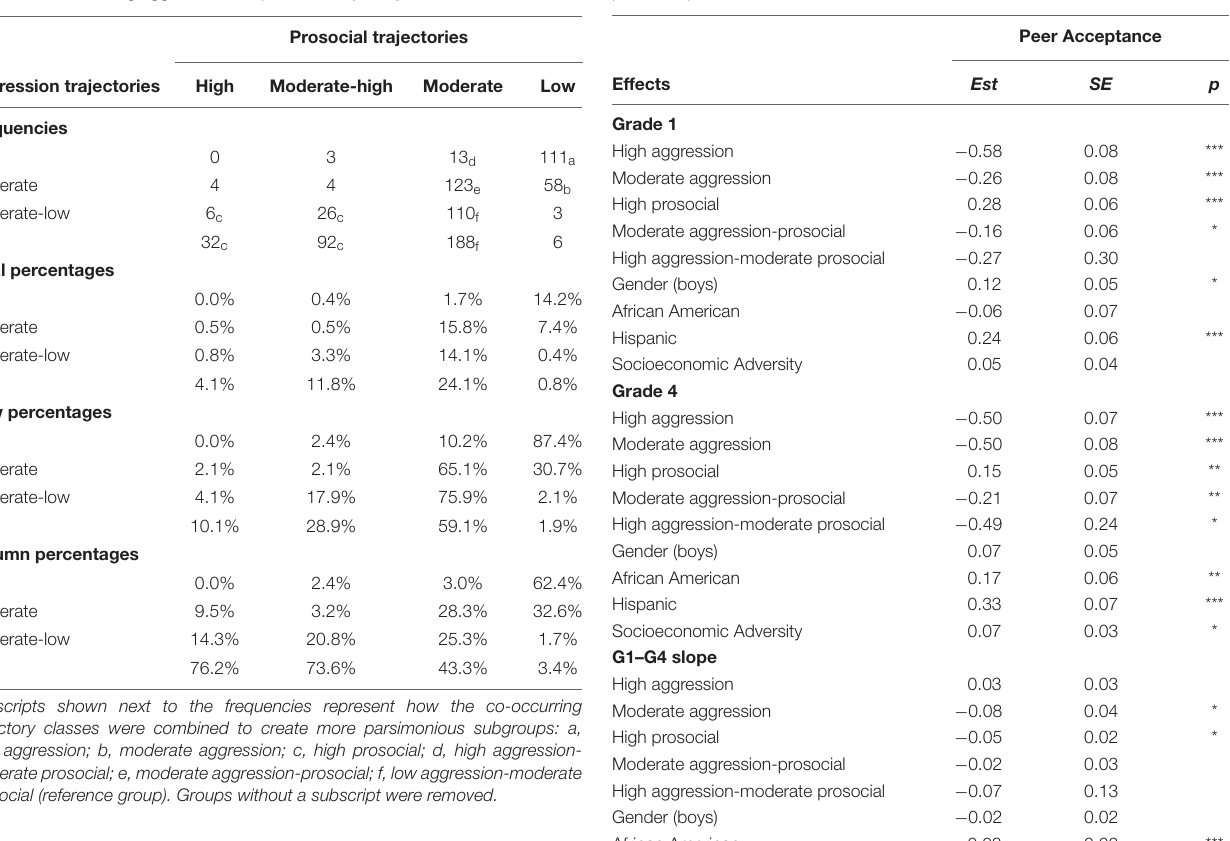
TABLE 4 | Estimates for conditional growth models examining children’s peer